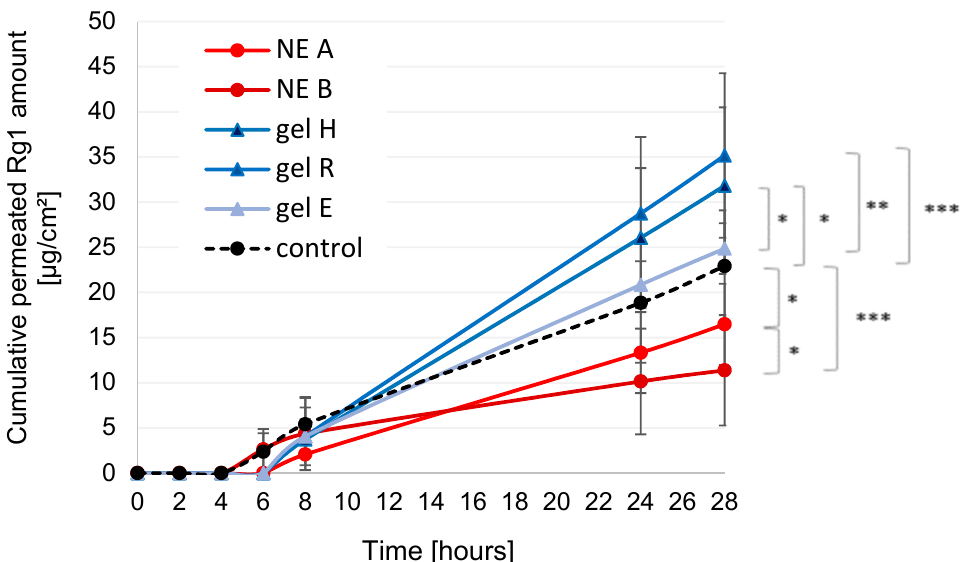
Figure 9. Permeation profiles of ginsenoside Rg1 from NEs, hydrogels and aqueous control solution (2% w / w of KRG extract, respectively). Cumulative permeated amounts of ginsenoside Rg1 in µ g · cm − 2 · h − 1 as determined by UHPLC/MS are plotted against experiment time. Light red circles: NE A_KRG, dark red circles: NE B_KRG, dark blue triangles: gel H_KRG, middle blue triangles: gel R_KRG, light blue triangles: gel E_KRG, black circles: control. Values represent means ± SD of n = 12 cells per formulation/control. Statistically significant differences of formulations against control and against each other after 28 h are marked with asterisks (* p < 0.05, ** p < 0.01, *** p < 0.001). Table 2. Total cumulative permeated Rg1 amounts after 28 h in µg·cm − 2 ·h − 1 and corresponding mean drug fluxes of NEs, hydrogels and aqueous control solution (2% w / w of KRG extract, respectively). Values represent means ± SD of n = 12 cells per formulation/control. Statistically significant differences of formulations against control after 28 h are marked with asterisks (* p < 0.05, ** p < 0.01, *** p < 0.001), factor of proportionality reflects enhancement factor of formulation versus control. Formulation Rg1 Amount After Sign. vs. Prop. Mean Rg1 Sign. vs. Prop.